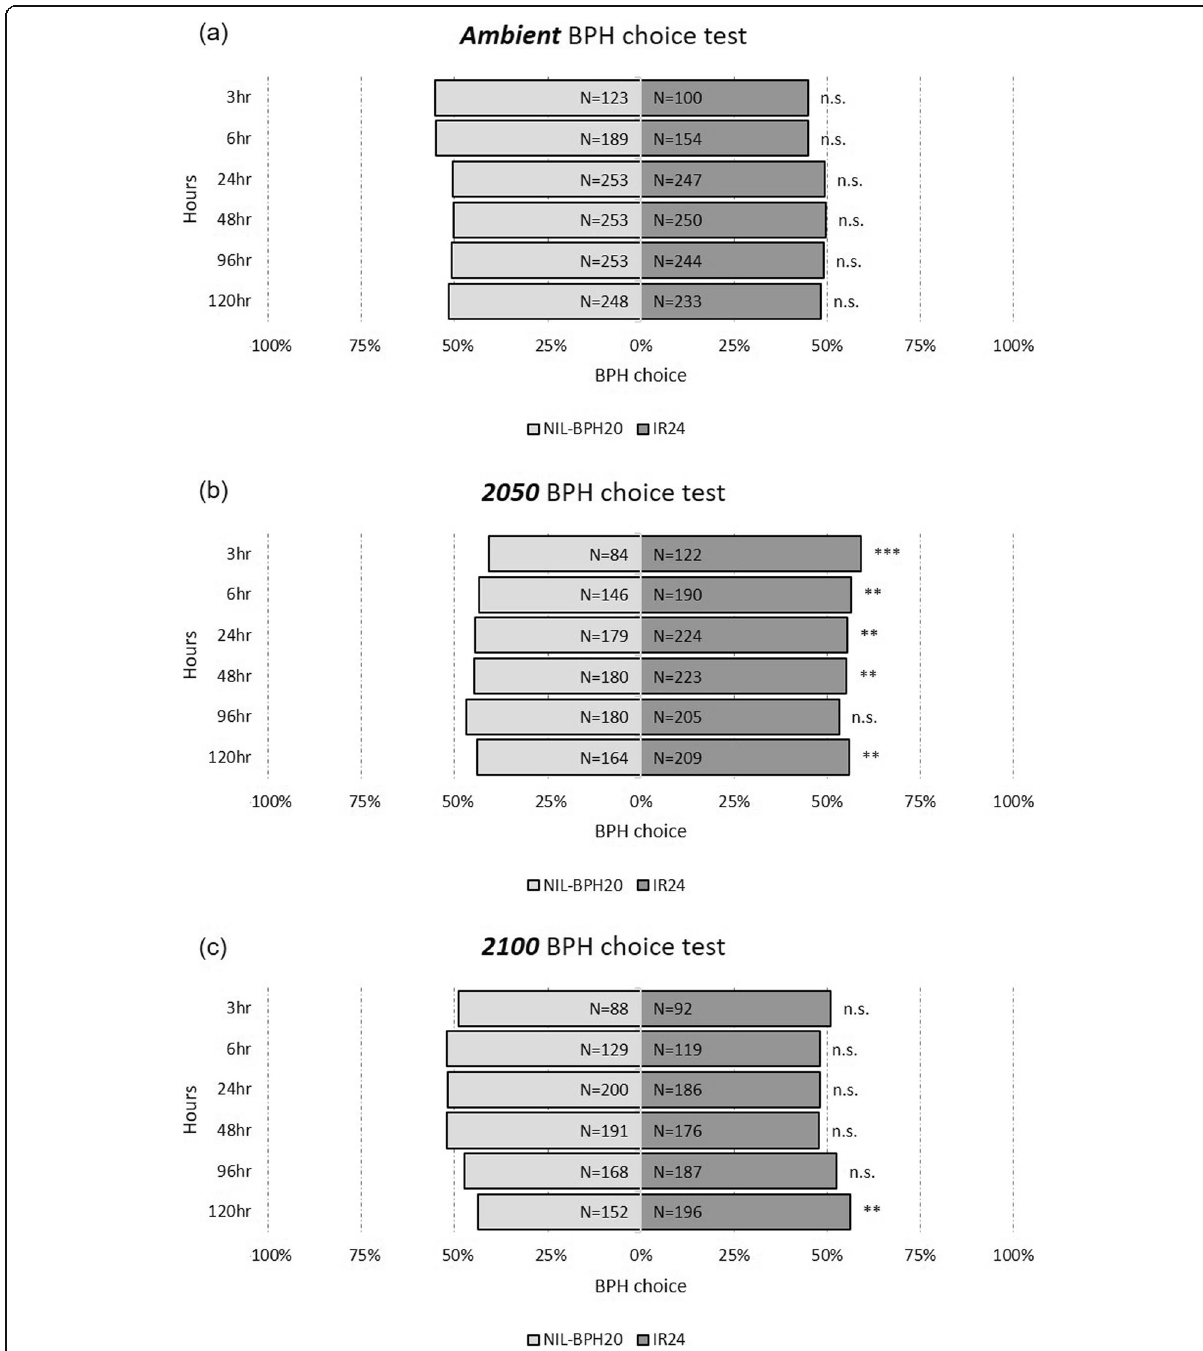
Fig. 8 The choice test of N. lugens nymphs on IR24 and NIL- BPH20 under different environments. a Ambient . b 2050 . c 2100 . Asterisks indicate differences between IR24 and NIL- BPH20 as: ** P < 0.01; *** P < 0.001; n.s. means